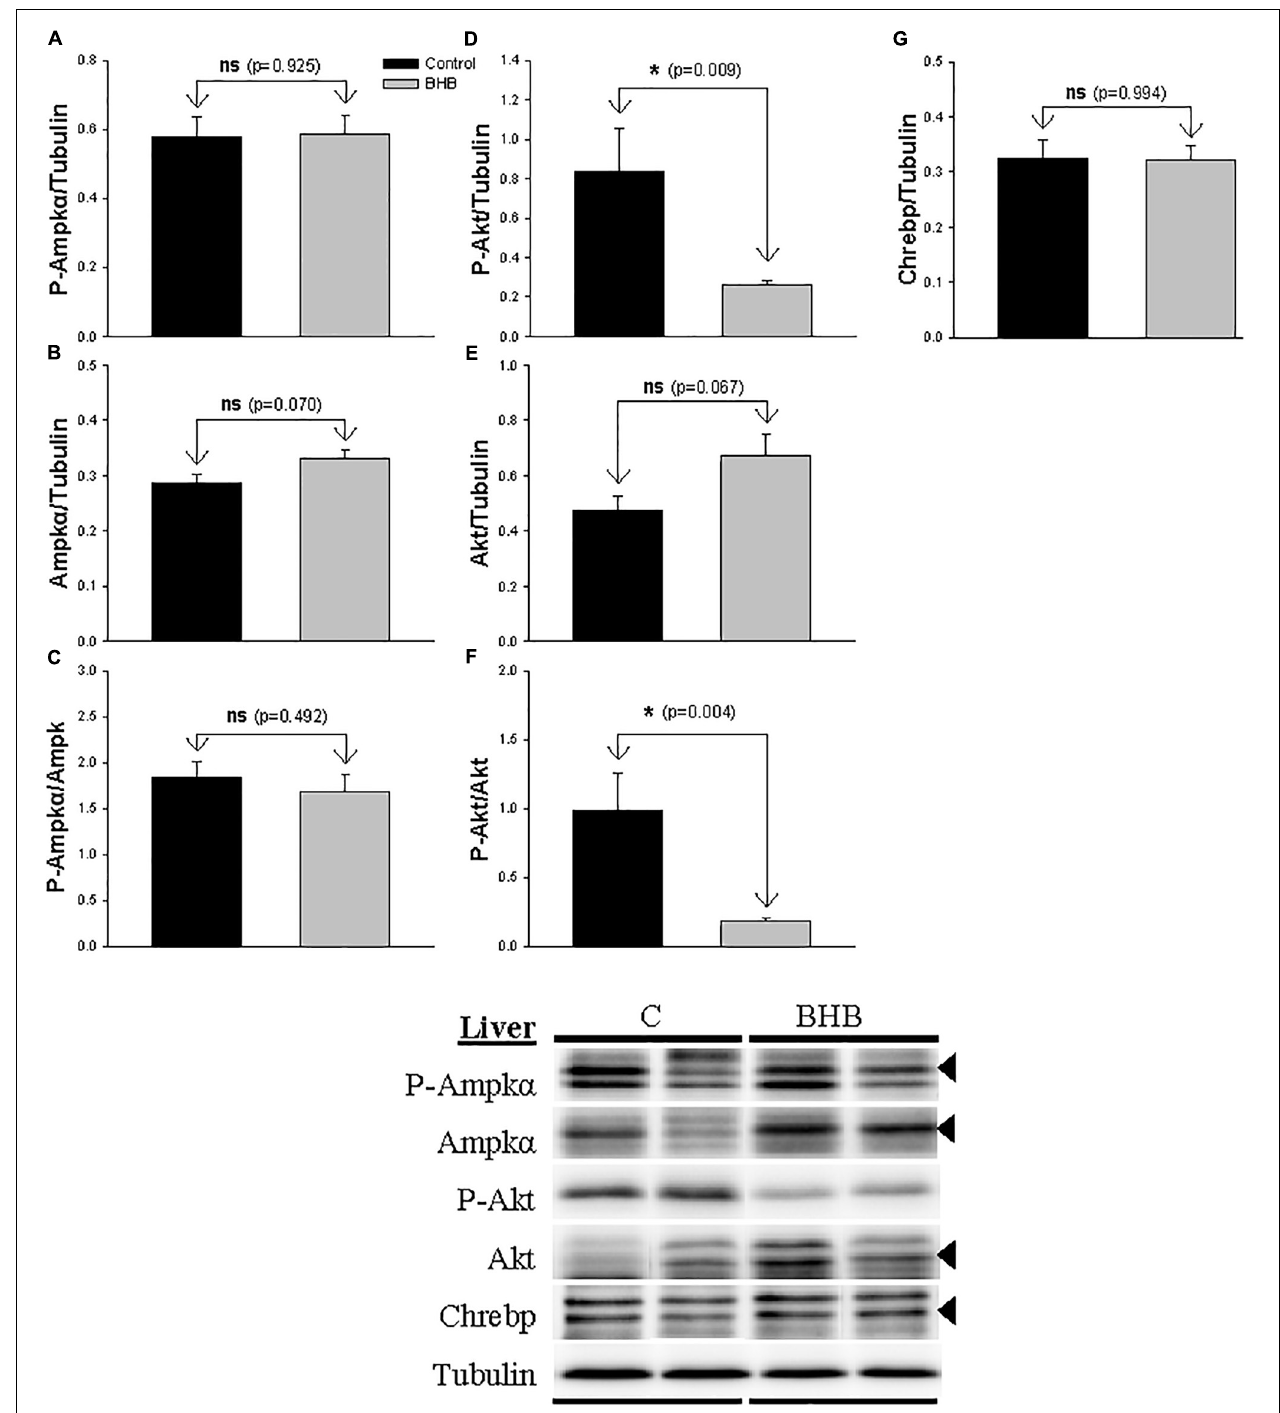
FIGURE 4 | Western blot analysis of Ampk α (A–C) , Akt (D–F) and Chrebp (G) protein levels in liver of rainbow trout 6 h after intracerebroventricular administration of 1 µ L 100 g – 1 body mass of saline solution alone (Control) or containing 0.5 µ mol of β -hydroxybutyrate (BHB). Ten micrograms of total protein were loaded on the gel per lane. Western blots were performed on six individual samples per treatment, and representative blots are shown. Graphs represent the amount of phosphorylated protein (A,D) , the total amount of the target protein (B,E,G) and the ratio between the phosphorylated protein and the total amount of the target protein (C,F) . Each value is the mean + SEM of n = 6 fish per treatment. ns, not significant difference. ∗ indicates significant differences ( p < 0.05) compared to control group.